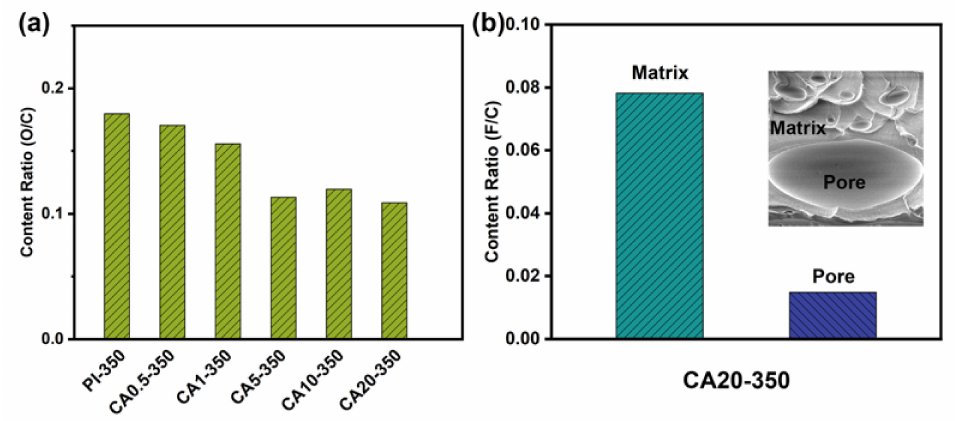
Figure 8. Element analysis of composite membranes at 350 ◦ C: ( a ) content ratio (O/C) of matrix; ( b ) content ratio (F/C) of matrix and pores for